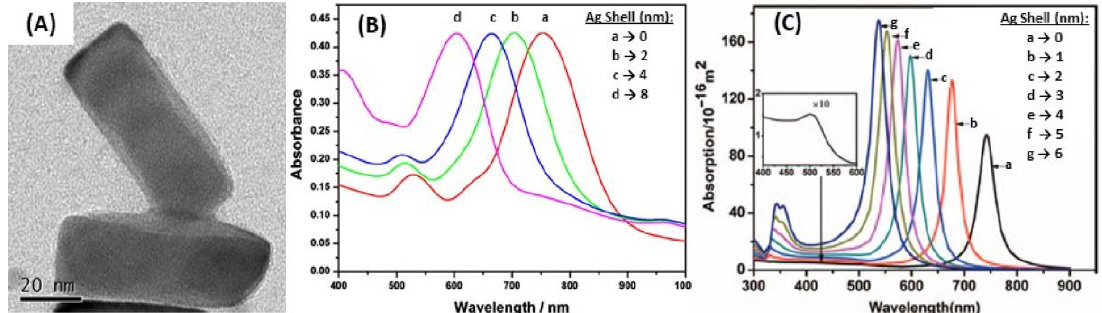
Figure 19. ( A ) TEM image of Au@Ag nanorods with 60 × 20 nm dimensions for the Au core and 4 nm thickness for the Ag shell and ( B ) variation of the extinction spectra of Au@Ag nanorods with varying Ag shell thickness (0–8 nm) on the 60 × 20 nm Au core. ( C ) The variations in the calculated LSPR spectra of Au@AgNRs with varying Ag shell thickness (0–6 nm) as well as the zoom on the spectrum allowed seeing the peak corresponding to the Au-Ag interface transversal resonance. Adapted from